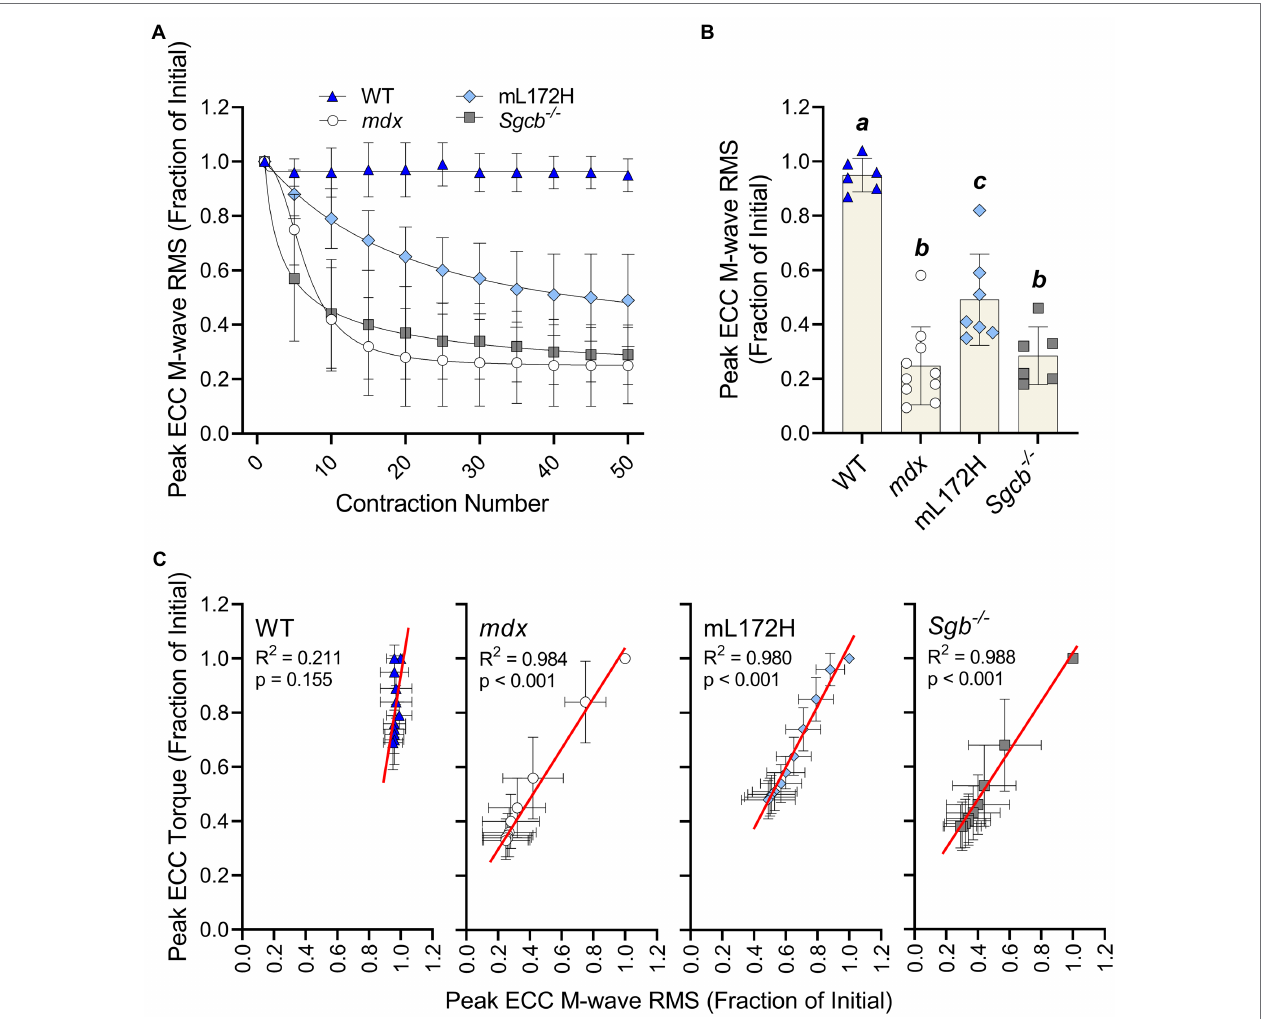
FIGURE 3 | Loss of M-wave RMS parallels loss of torque in dystrophic mouse lines. (A) M-wave RMS in WT, mdx , mL172H, and Sgcb − / − mice over 50 maximal ECC contractions. (B) Peak ECC M-wave RMS expressed as a fractional change from the first to fiftieth contraction. (C) Regression analysis of peak ECC torque and M-wave RMS in WT and dystrophic mouse lines. Groups with the same letter are not significantly different from each. Significance was set at p < 0.05. Bars are mean ±